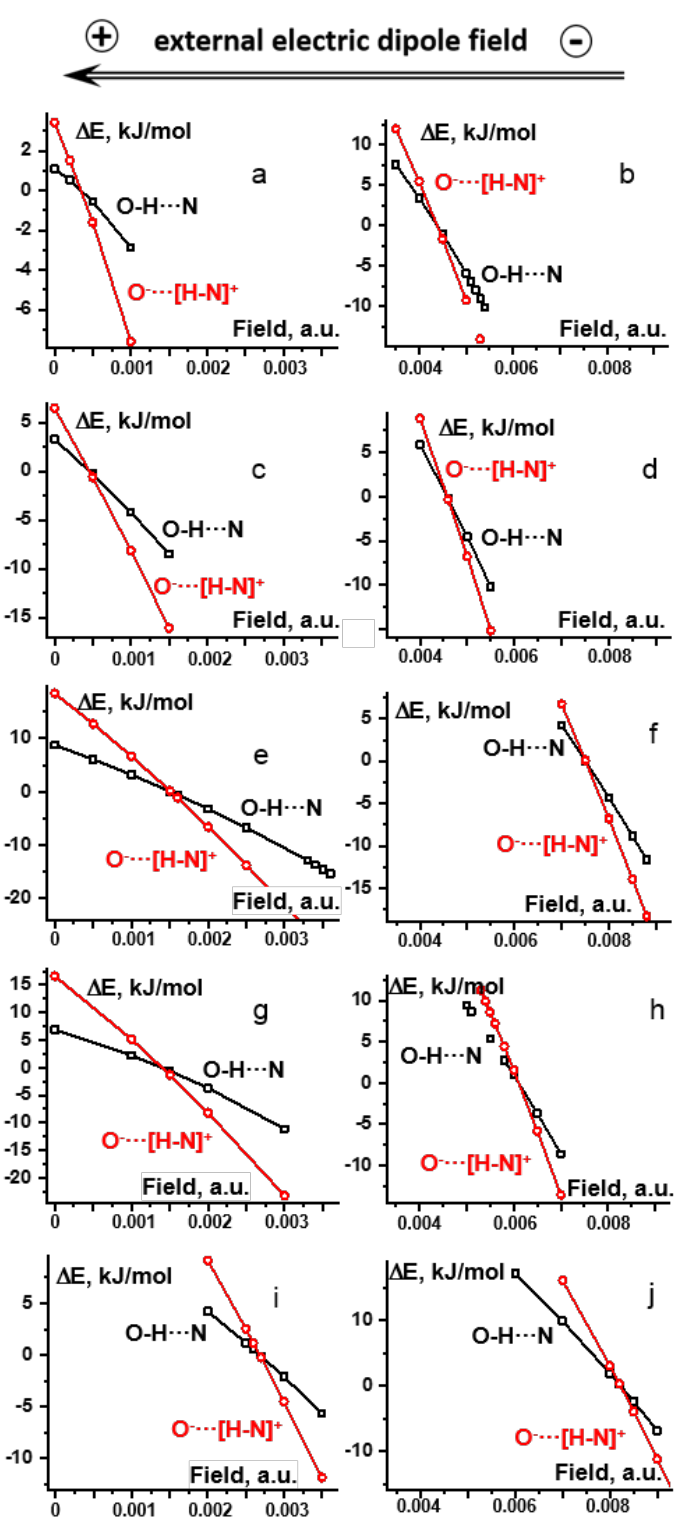
Figure 4. The effect of the external electric field on the energy of O-H···N (black □) and O − ···[H-N] + (red ○ ) forms of H-bonds in 2 – 6 . For each complex, there is a unique value of the field strength for which the energy minima of the two forms are equal. ∆ E corresponds to the energy with respect to the value at this field. 2 : ( a ) PCM ( ε = 12.5), ( b ) gas-phase; 3 : ( c ) PCM ( ε = 29.3), ( d ) gas-phase; 4 : ( e ) PCM ( ε = 29.3), ( f ) gas-phase; 5 : ( g ) PCM ( ε = 29.3), ( h ) gas-phase; 6 : ( i ) PCM ( ε = 29.3), ( j ) gas-phase.